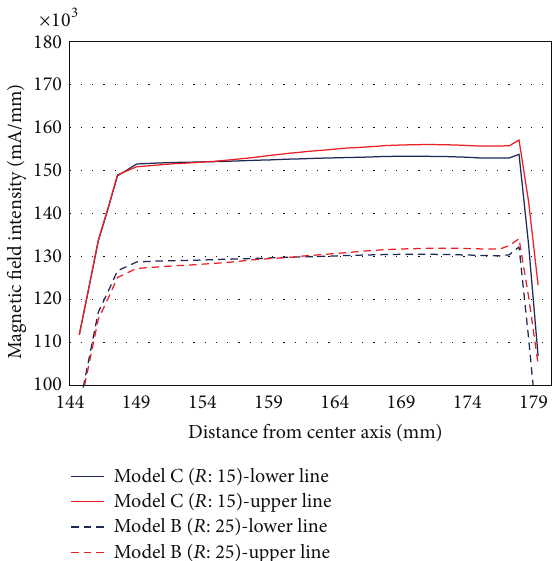
Figure 12: Magnetic field intensity (MFI) as a function of the radial distance from the center axis.